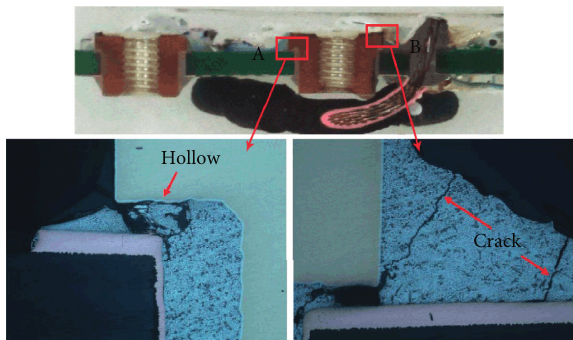
Figure 13: SEM micrograph of the cracks on the power control board